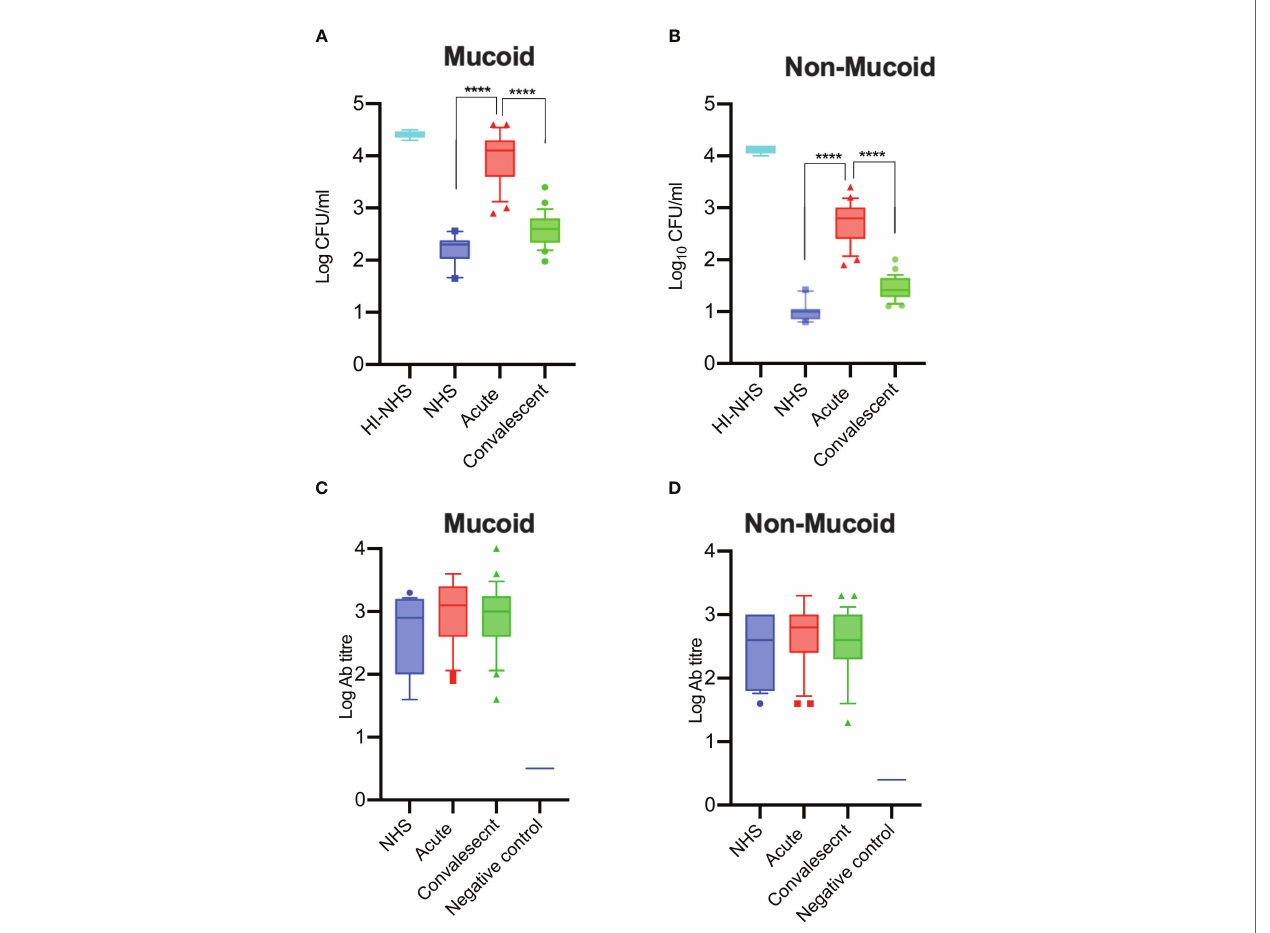
FIGURE 7 | Serum bactericidal activity of sera from COVID-19 patients in the acute phase of severe disease is impaired and has recovered in convalescent sera. Complement-mediated killing of mucoid (A) and non-mucoid (B) strains of K. pneumoniae is signi fi cantly impaired in sera from acute patients compared to recovered patients in convalescence (n = 25 paired acute/convalescent patients). NHS (n = 12) and HI-NHS were used as controls. High antibody titres against K. pneumoniae species were detected in all 25 sera of patients with severe COVID-19 (C-D). An individual NHS sample with no detectable antibody titres against K. pneumoniae was used as a negative control (C, D) . Results were analysed using 1-way ANOVA, with Dunnett ’ s correction for multiple comparisons. **** p <